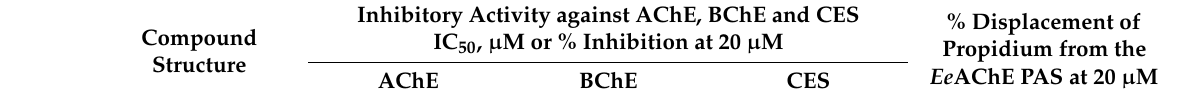
Table 1. Esterase profile of compounds 2,6,7,8 and their ability to displace propidium iodide from the peripheral anionic site of Electrophorus electricus AChE ( Ee AChE).